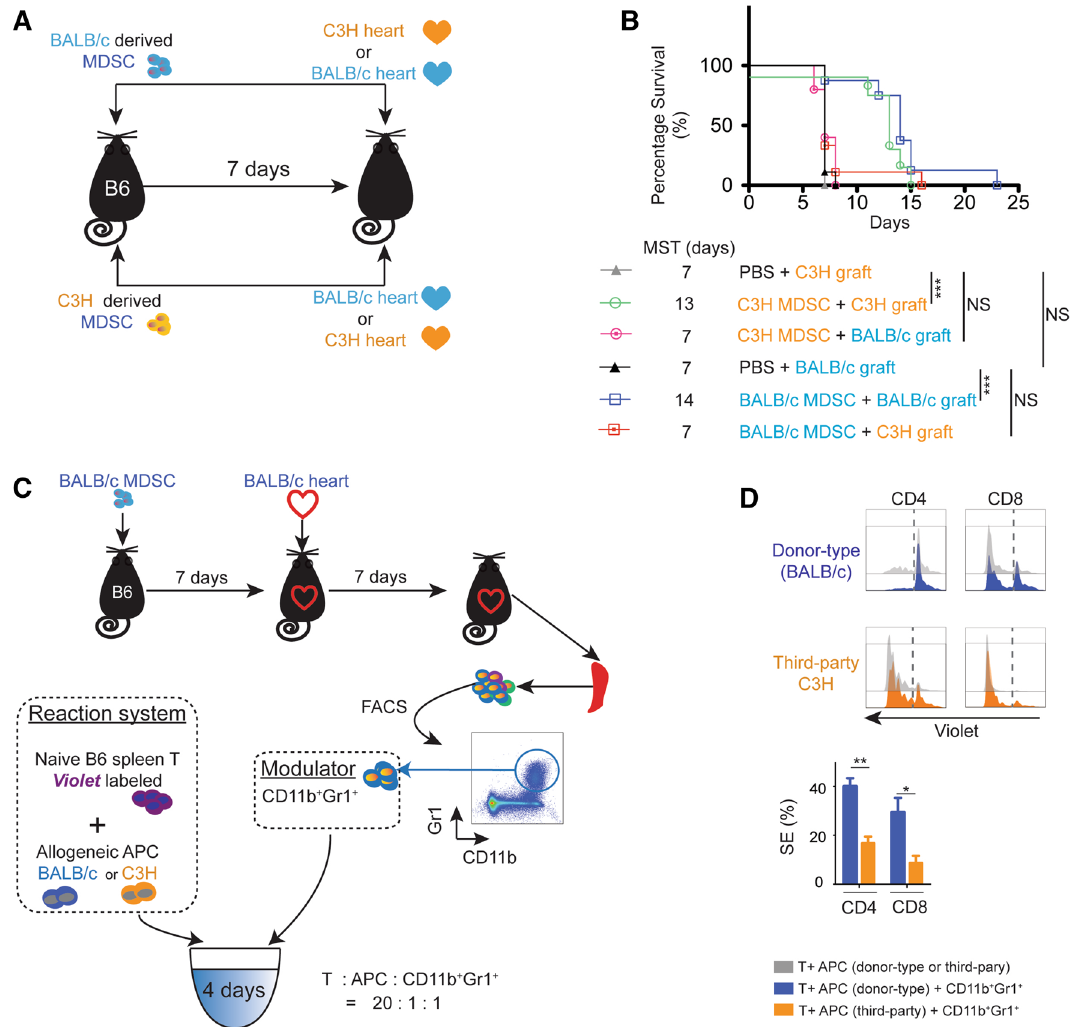
Figure 5. Donor-derived MDSCs prolong allogeneic cardiac graft survival in a donor-specific manner. ( A ) Schematic diagram of the experimental design. C57BL/6 mice received a single-dose intravenous injection of 1 × 10 6 BALB/c or C3H MDSCs. Cardiac grafts from C3H or BALB/c mice were transplanted into pre-sensitized C57BL/6 recipients. ( B ) Kaplan–Meier cumulative survival of allograft showing that the BALB/c MDSCs administration successfully prolong BALB/c allograft survival but fail to prolong C3H allograft survival, while C3H MDSCs administration prolong C3H allograft survival but fail to prolong BALB/c allograft survival. *p < 0.05, **p < 0.01, ***p < 0.001, log-rank test. ( C ) Schematic illustration of the experimental design to study the e x vivo donor-specific immunosuppressive function of donor MDSCs induced endogenous MDSCs (CD11b + Gr1 + ). Naïve C57BL/6 spleen T cells were labeled with CellTrace violet and were stimulated with BALB/c cDCs or C3H cDCs (third-party). CD11b + Gr1 + cells were isolated by FACS from BALB/c MDSCs treated C57BL/6 recipient splenocytes at POD7 (n = 3–4 per group) and were added as modulator. ( D ) CD4 + and CD8 + T cell proliferation in response to primary donor-type BALB/c cDCs or third-party C3H cDCs was analyzed by CellTrace violet dye dilution. Graphs showed the attenuated suppression efficiency (SE) of ( w / oMDSC ) − p ( MDSC ) × 100% CD11b + Gr1 + cells in third-party compared to donor-type allo MLR setting. SE = p p ( w / oMDSC )